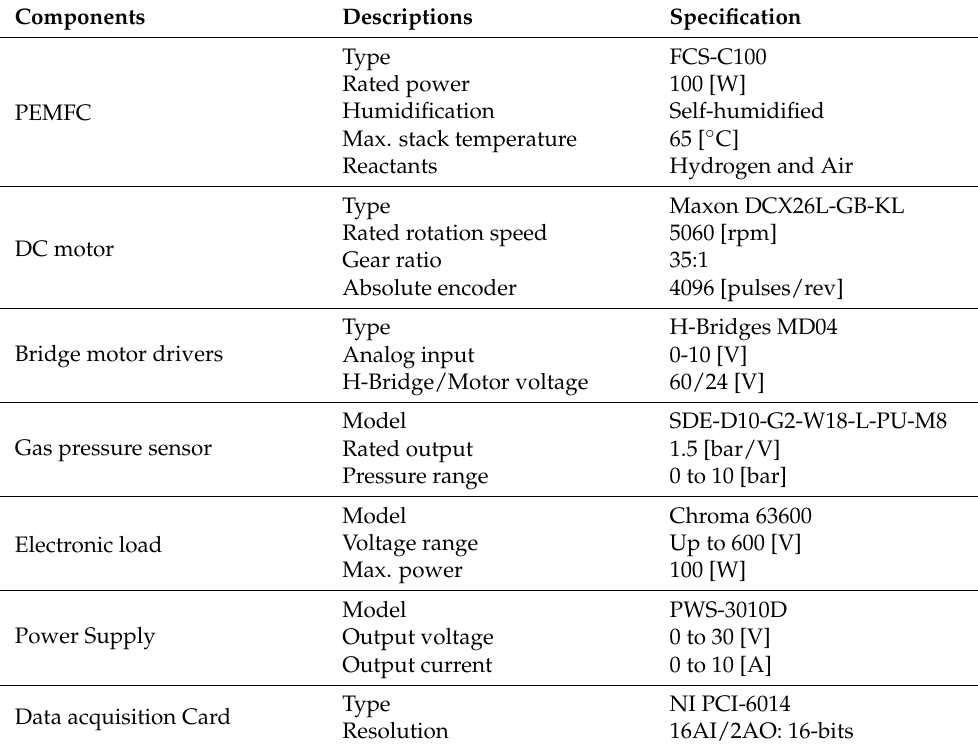
Figure 8. Experimental apparatus: 1-Oscilloscope; 2-Power supply; 3-Electronic load; 4-PEMFC H100; 5-DC servo motor; 6-Supply manifold; 7-Pressure transducers; 8-Current sensor; 9-NI Data acquisition; 10-Servo valve; 11-Pressurized hydrogen tank; 12- Program computer with Chroma & Simulink; 13-Control box. Table 2. Devices setting of the practical PEMFC system.